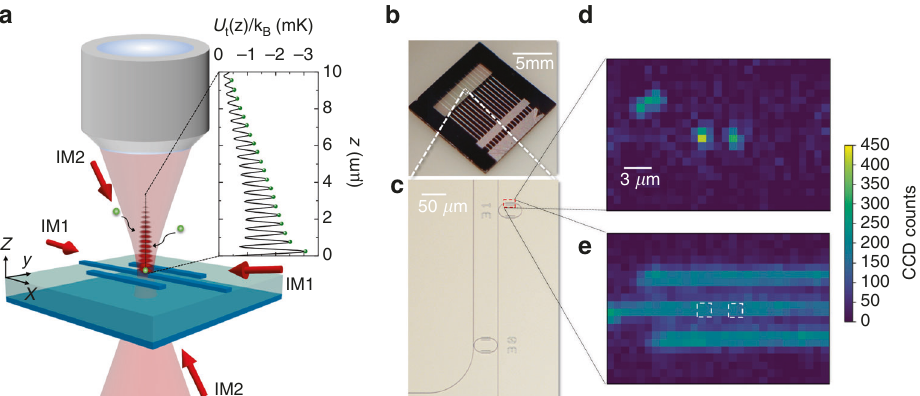
Fig. 1 Single-atom trapping and imaging on a planar dielectric nanostructure. a Simpli fi ed schematic of the microscope objective (numerical aperture NA = 0.35) projecting a tightly focused optical tweezer beam (1/ e 2 beam waist 1.2 μ m) onto a planar photonic structure. Light and dark shaded rectangles represent SiO 2 and Si 3 N 4 dielectric structures, respectively. Due to fi nite surface re fl ectance, a lattice of micro-traps (dark red shaded region) forms within the tweezer potential. Inset shows the potential line-cut U t ( z ) through the center of the tweezer lattice. Single atoms (green spheres) are cooled and loaded into the traps and are fl uorescence imaged while scattering photons from a pair of counter-propagating, near-resonant beams (red arrows marked by either IM1 or IM2). b The photonic membrane circuit. A zoom-in view within the dashed box is shown in c , where sample planar structures in the top-layer of the membrane are visible. d Atomic fl uorescence image (using IM1) of two adjacent, loaded tweezer traps focused in the red box region as illustrated in c . e Bright fi eld image of the nanostructure recorded under the identical image focus and fi eld of view; see Methods. Dashed boxes mark the location of the atoms in d . Pixel size: (800 nm)